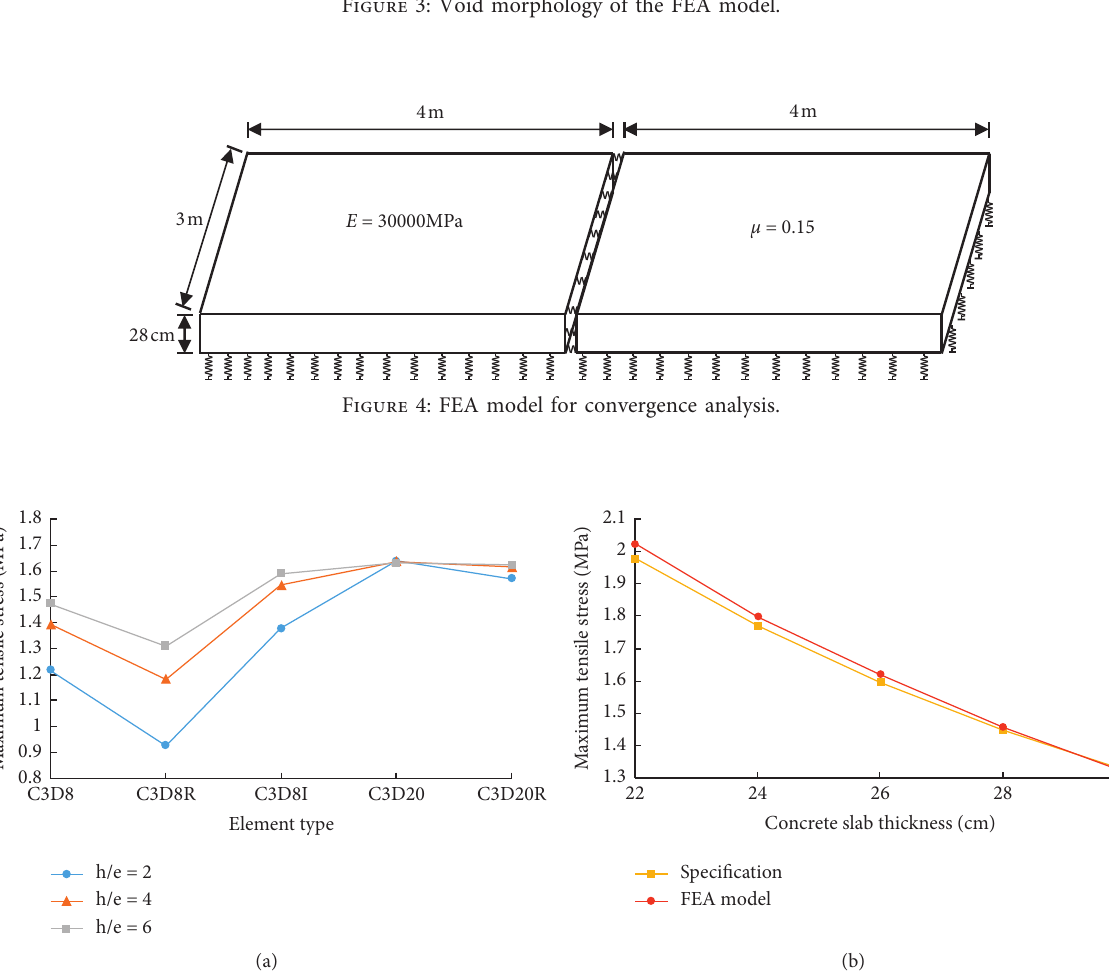
Figure 5: The results of the convergence analysis. (a) The convergence analysis. (b) The verification of C3D8I